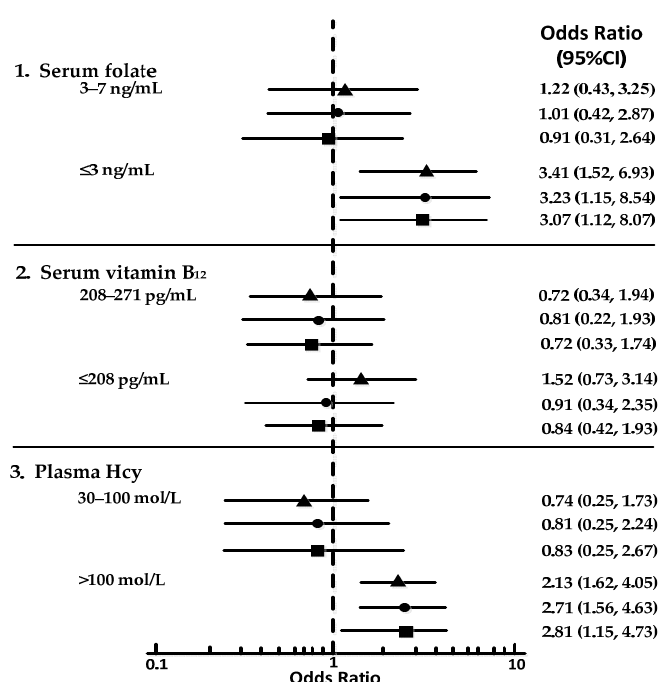
Figure 3. Forest plots showing ORs for tertiles of the vitamin and Hcy levels in MCI. 1 indicates comparing to tertile of >7 ng/mL; 2 indicates comparing to tertile of >271 pg/mL; 3 indicates comparing to tertile of ≤ 30 mol/L. This figure illustrates unadjusted model （ ▲ ）， adjusted model for age, sex, and education （ ● ） ; and adjusted model for age, sex, education, folate, vitamin B 12 , and Hcy （ ■ ） .